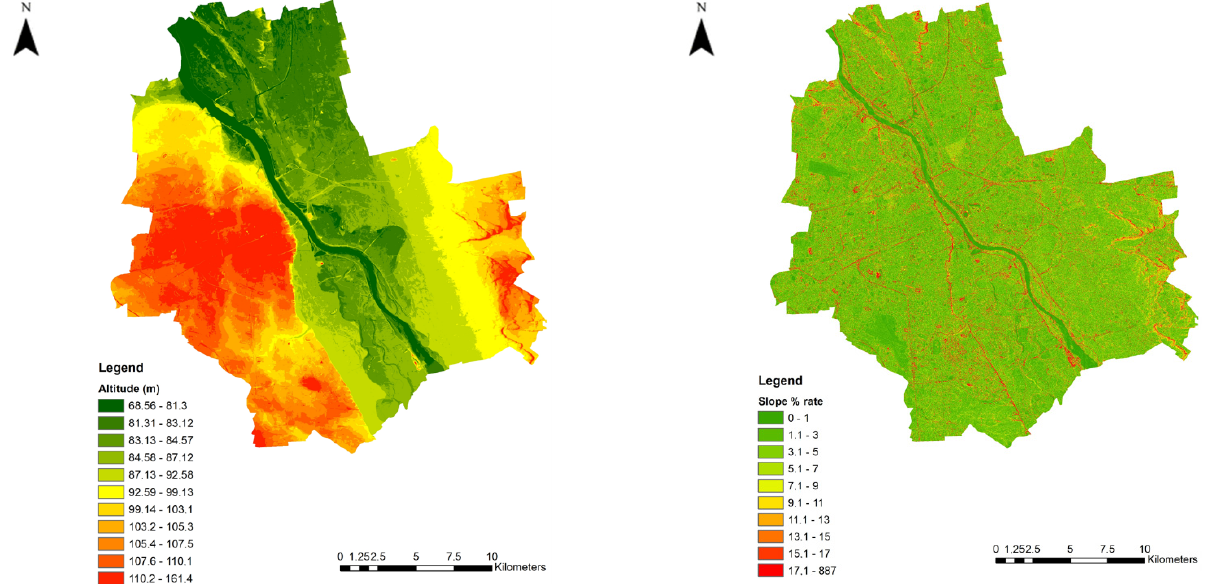
Figure 7. Digital Elevation Model (DEM) and slope (% rate) map for the city of Warsaw. The digital elevation model and the slope (% rate) maps for the Słu˙zewiecki catchment are presented in Figures A3 and A4 in Appendix